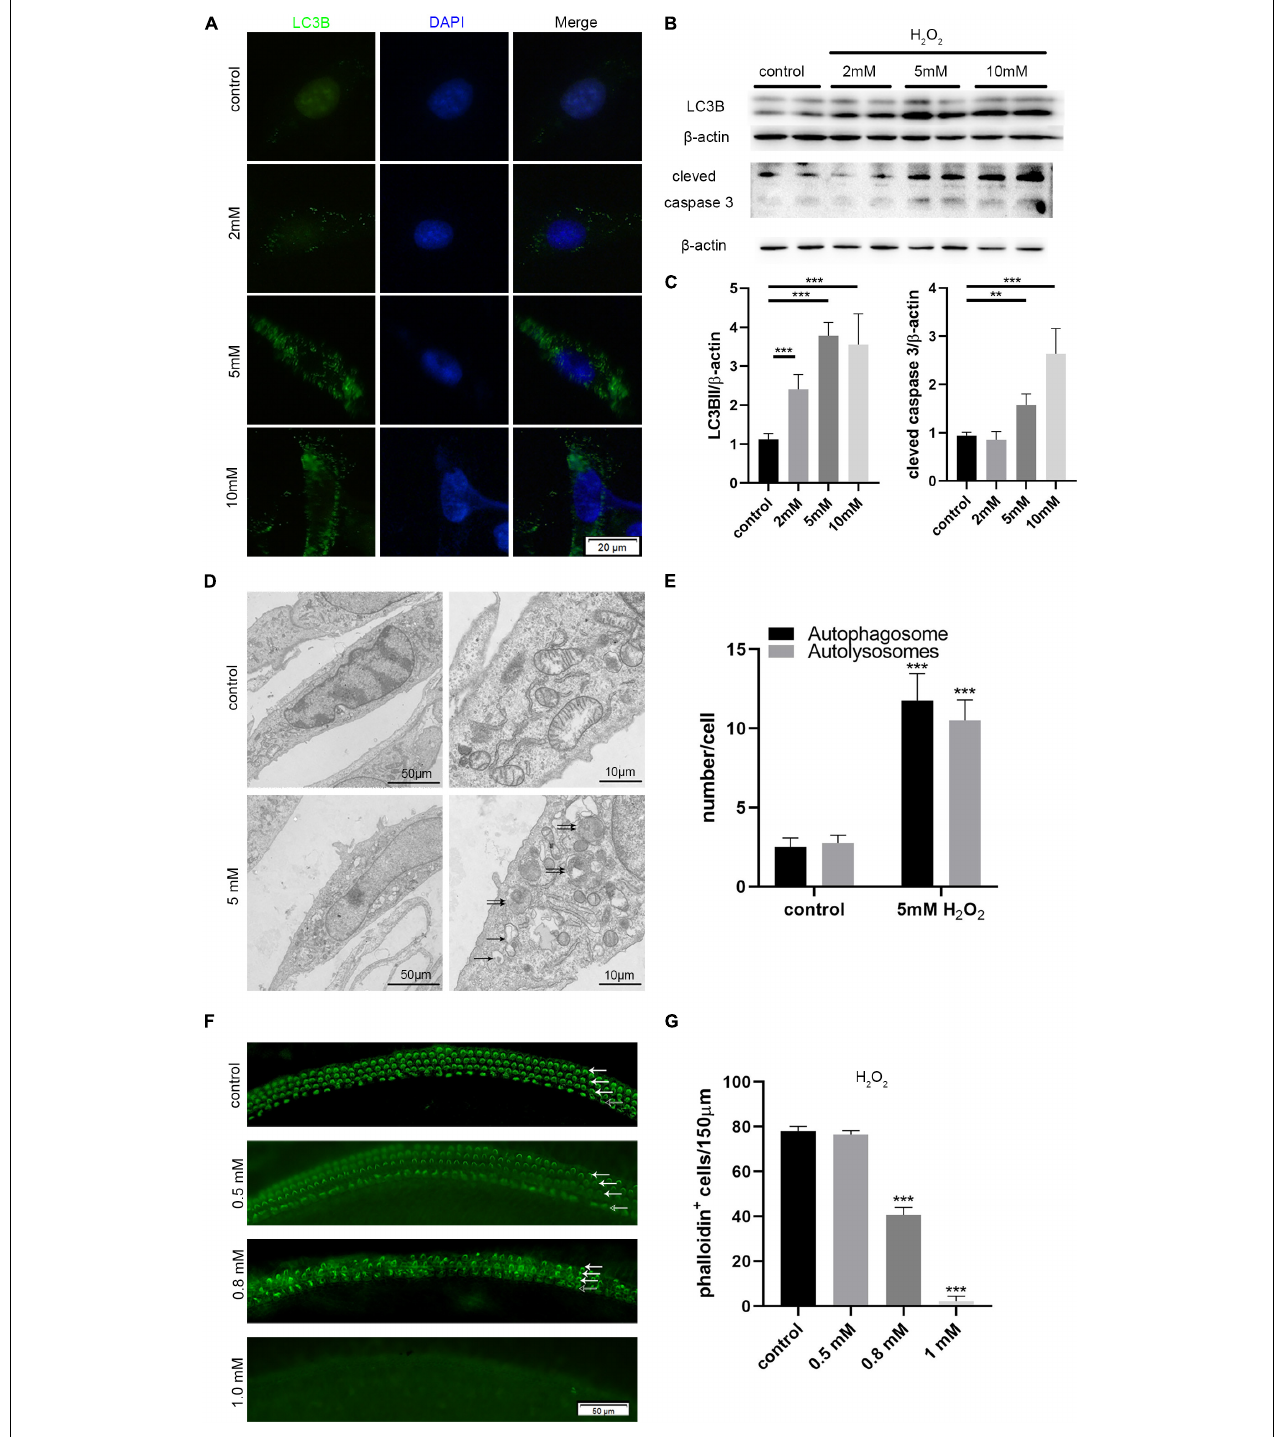
FIGURE 6 | Increased autophagy and apoptosis in the HEI-OC-1 cells and cochlear hair cells (HCs) after H 2 O 2 treatment. (A,B) Immunofluorescence of LC3B expression in the HEI-OC-1 cells treated with different concentrations of H 2 O 2 (2 mM, 5 mM and 10 mM), and the western-blotting analysis of LC3B and cleaved caspase 3. (C) Quantification analysis of (B) , showing the ratios of LC3B II or cleaved caspase 3 to β -actin ( n = 4). (D) Transmission electron microscope (TEM) evaluating autophagy in HEI-OC-1 cells treated with 5 mM H 2 O 2 . (E) Quantification of the results in (D) . The numbers of autophagosomes (arrow in pictures) and autolysosomes (double arrows in pictures) were significantly increased after treatment compared with the control, n = 3. (F) Phalloidin labeling showing HCs survival in the cochlea after H 2 O 2 (0.5 mM, 0.8 mM, 1 mM) damage. OHCs, solid arrows; IHCs, blank arrows. (G) Quantification of the phalloidin-positive HCs in (F) , n = 3. The data are shown as the mean ± SD. Two-tailed, unpaired Student’s t -tests were used to determine statistical significance.